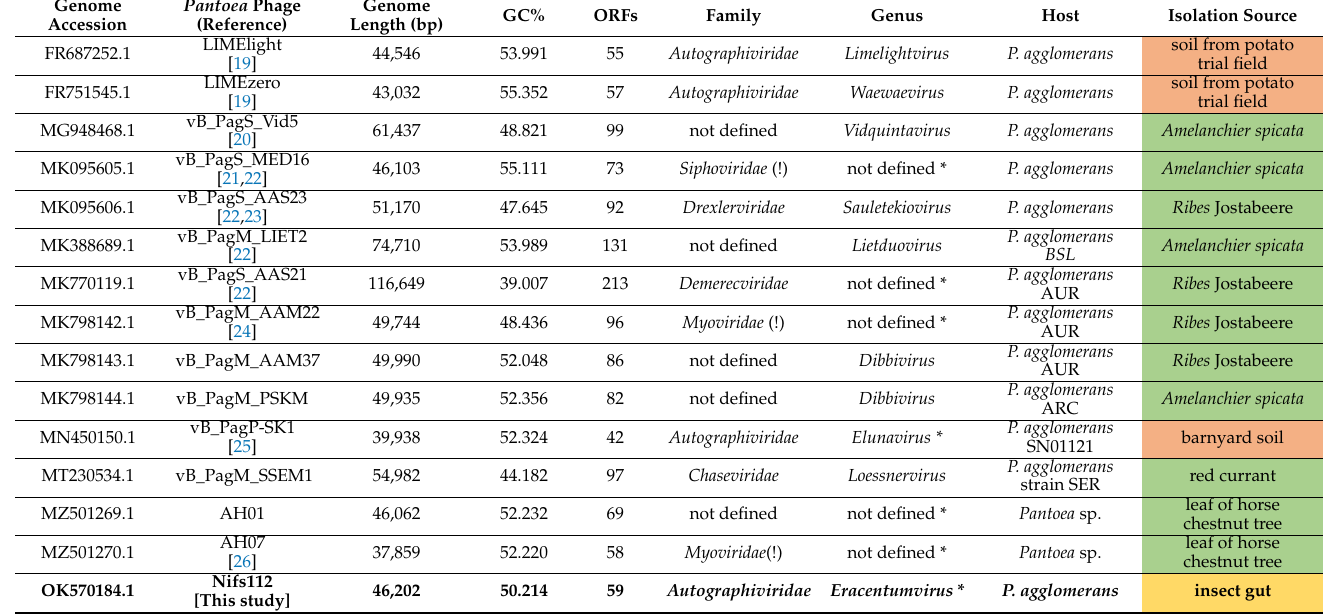
Table 1. Overview of the so-far publicly available completely sequenced phages infecting bacteria from genus Pantoea . Rows containing information about phages Nifs112, Nufs112, and Nafs113 described in this study are in bold. “ Pantoea phage” column provides a reference with further details about a particular phage, if such a reference could be found. Taxonomy was retrieved from the genome accession metadata, and the exclamation mark (!) after some of the family names indicates that this phage family was recently abolished by the ICTV. An asterisk (*) in the genus column indicates that the corresponding phage is not a part of the official phage taxonomy as per (VMR VMR_20-190822_MSL37.3). Isolation source column cells are colored based on the isolation source category: brown—soils; green—plant-associated material; yellow—insect-associated material; blue—water-associated source.